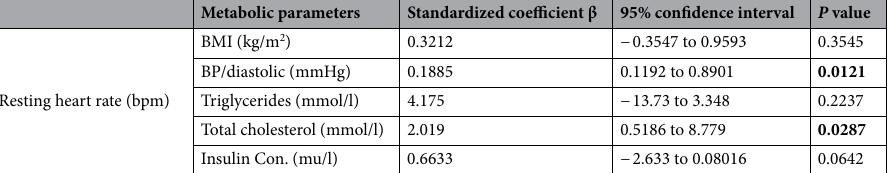
Table 3. Multiple linear regression analysis: RHR as dependent variable, relative to clinical parameters. All values are means ± standard deviations unless labeled otherwise. BMI body mass index, BP blood pressure. Bold values denote statistical